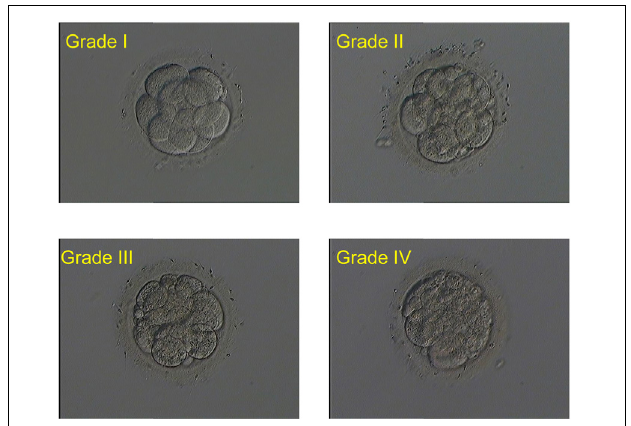
FIGURE 1 | Embryos at day 3 in different grades. Magnification at 200x.